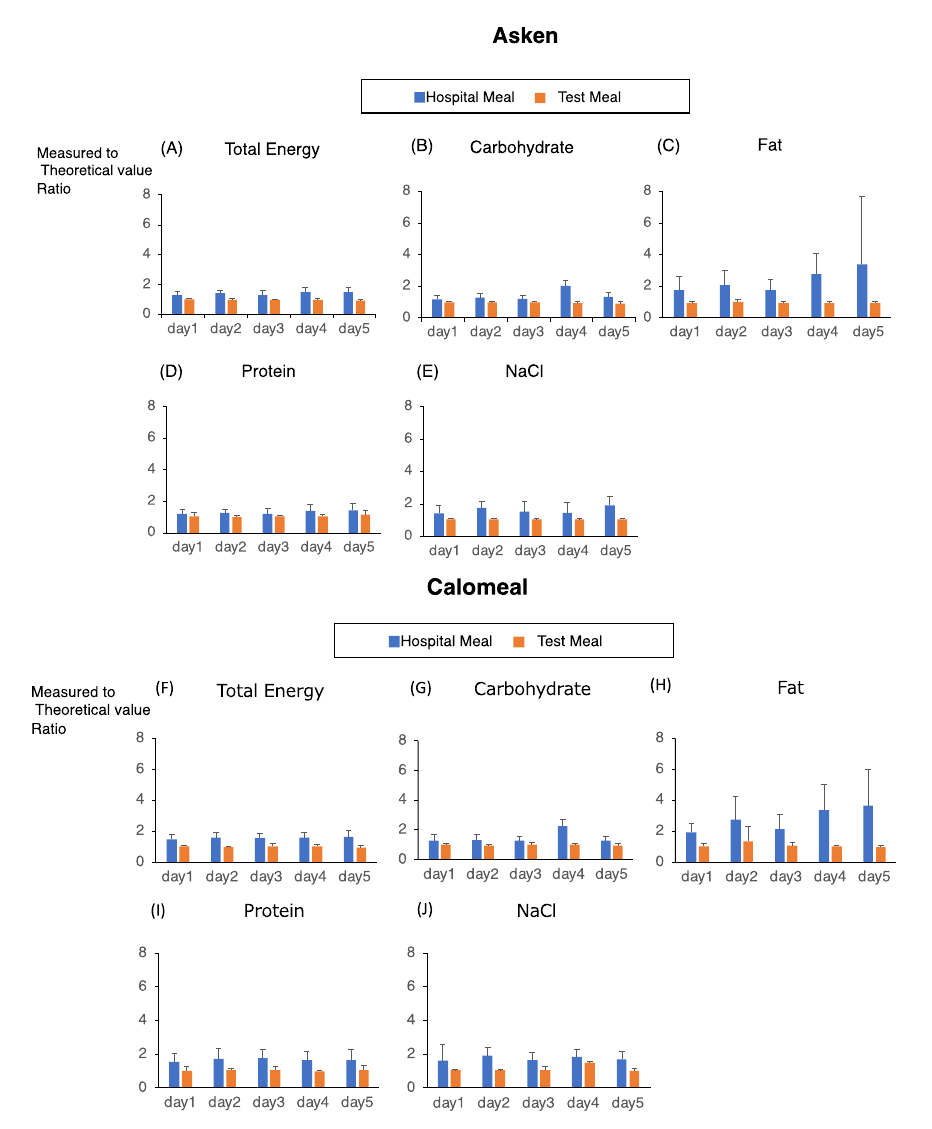
Figure 2. Measured vs. theoretical values of total energy and each nutrient for the hospital meal and test meal. The y-axis indicates the value obtained by dividing the actual value (measured value) obtained by the application by the true value (theoretical value) displayed on the food. If this value exceeded 1, then it indicated overestimation, and if it was less than 1, then it indicated underestimation. The blue lines show the hospital food, and the orange lines show the test food. Asken results are shown in the upper panel, and the unmatched results are shown in the lower panel. Each data point was measured by the Asken ( A – E ) or Calomeal ( F – J ) app. ( A , F ) total energy; ( B , G ) carbohydrates; ( C , H ) fat; ( D , I ) protein; ( E , J )